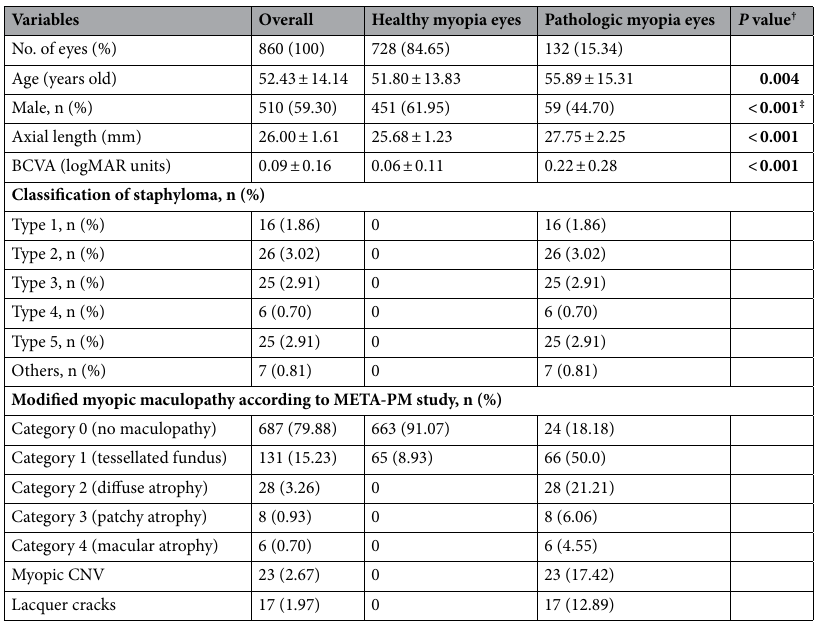
Table 1. Comparison of demographics and clinical features between patients with and without pathologic myopia. BCVA best corrected visual acuity, CNV choroidal neovascularization, No. number. Data are presented as mean ± standard deviation unless otherwise indicated. † Independent t -test for continuous variables. ‡ χ 2 test for categorical variables. § statistically significant values ( P < 0.05) are shown in bold.